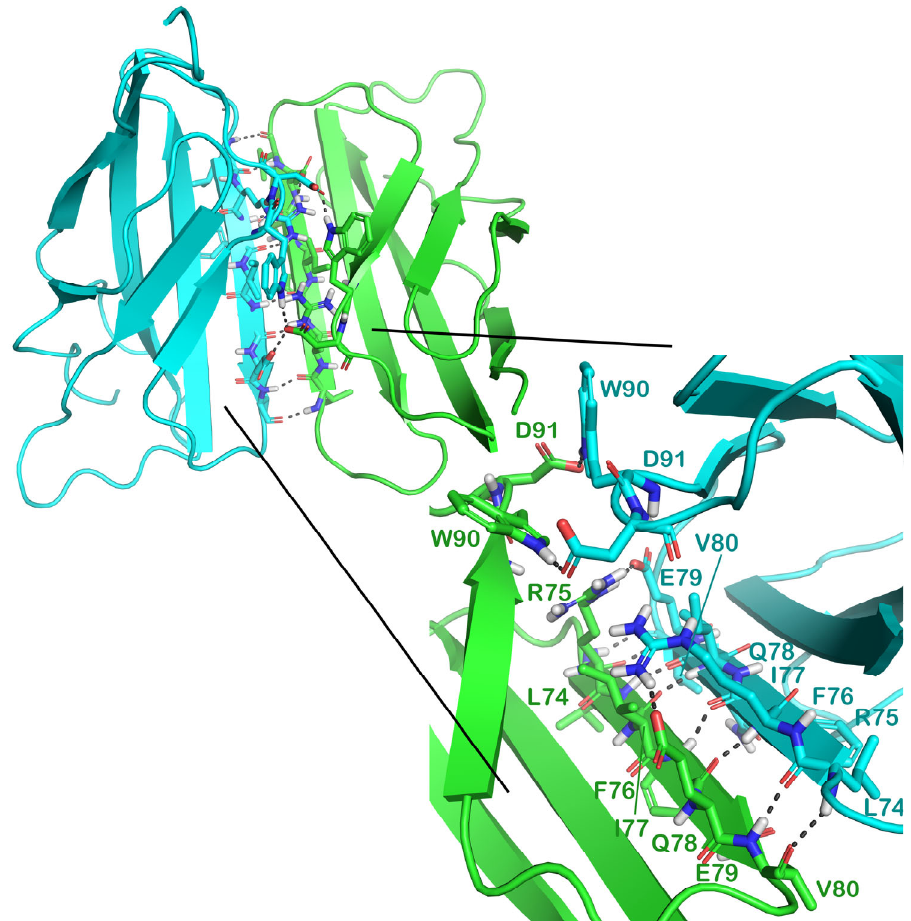
Figure 2. Representation of the irisin dimer, highlighting the interacting surface and related key amino acids: The irisin dimer is represented as a cartoon (PDB ID 4LSD), and each monomer is differently colored, while the interacting amino acids are represented by sticks and the H bonds are indicated as grey dotted lines. The image was generated using PyMOL (the PyMOL Molecular Graphics System, v1.8; Schrödinger, LLC, New York, NY, USA, 2015).